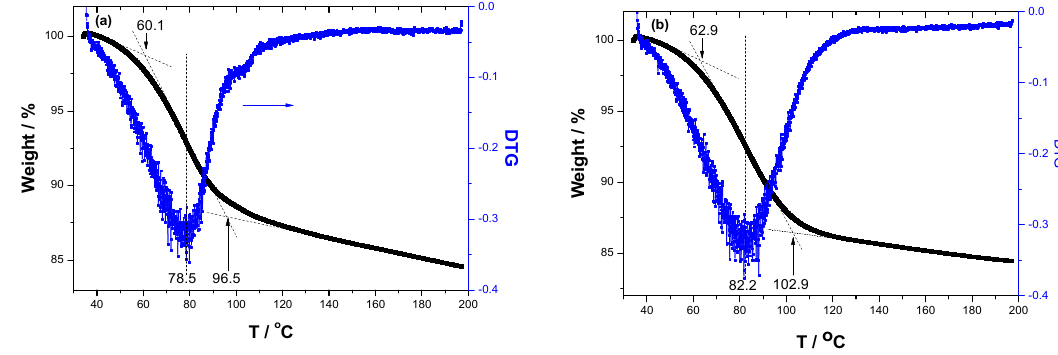
Figure 5. TG/DTG curves of samples including ( a ) S2 and ( b ) S5.